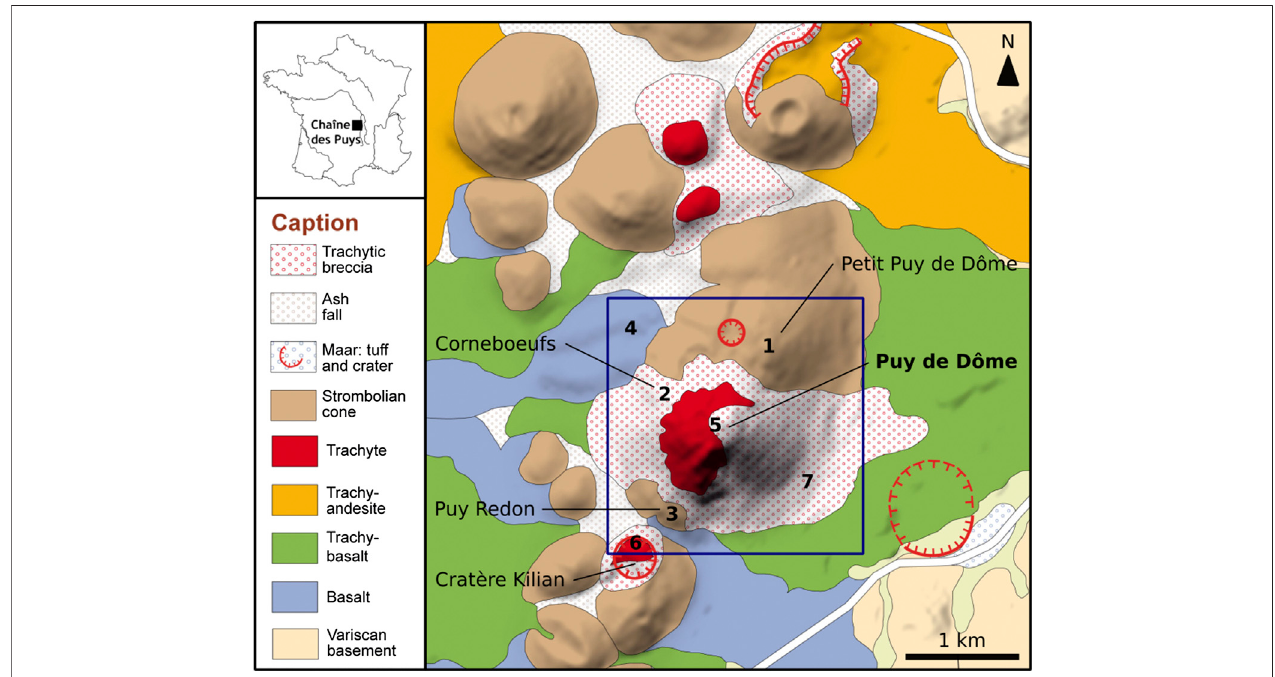
FIGURE 1 | Simpli fi ed geological map of the Puy de D ˆ ome and neighboring cones, adapted from Boivin et al. (2017). Top left: Location of the Cha ˆ ı ne des Puys in France. Blue square: Study area of the present paper ( Figures 2 , 7 ).